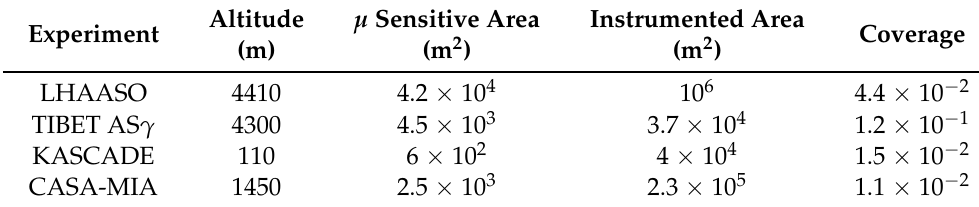
Table 2. Characteristics of different muon detectors operated in some shower